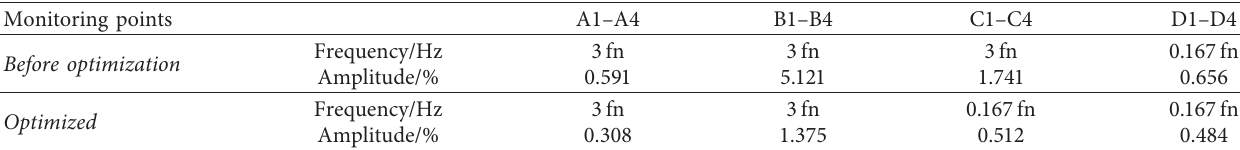
Table 10: Maximum amplitude of pressure pulsation at each monitoring point before and after